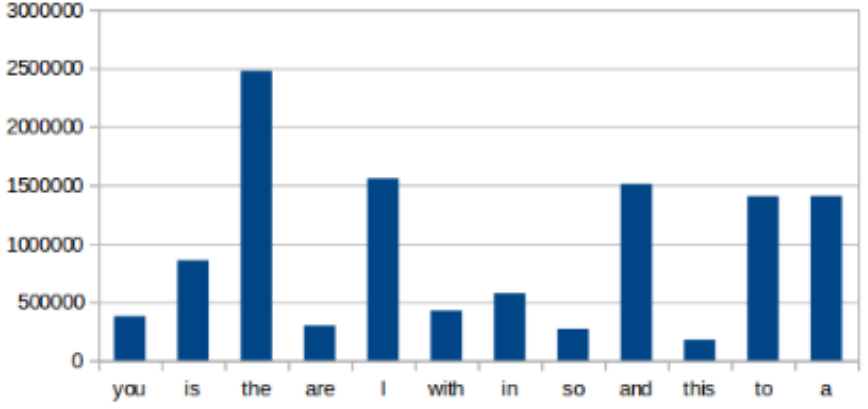
Figure 3. Skewed key size example.